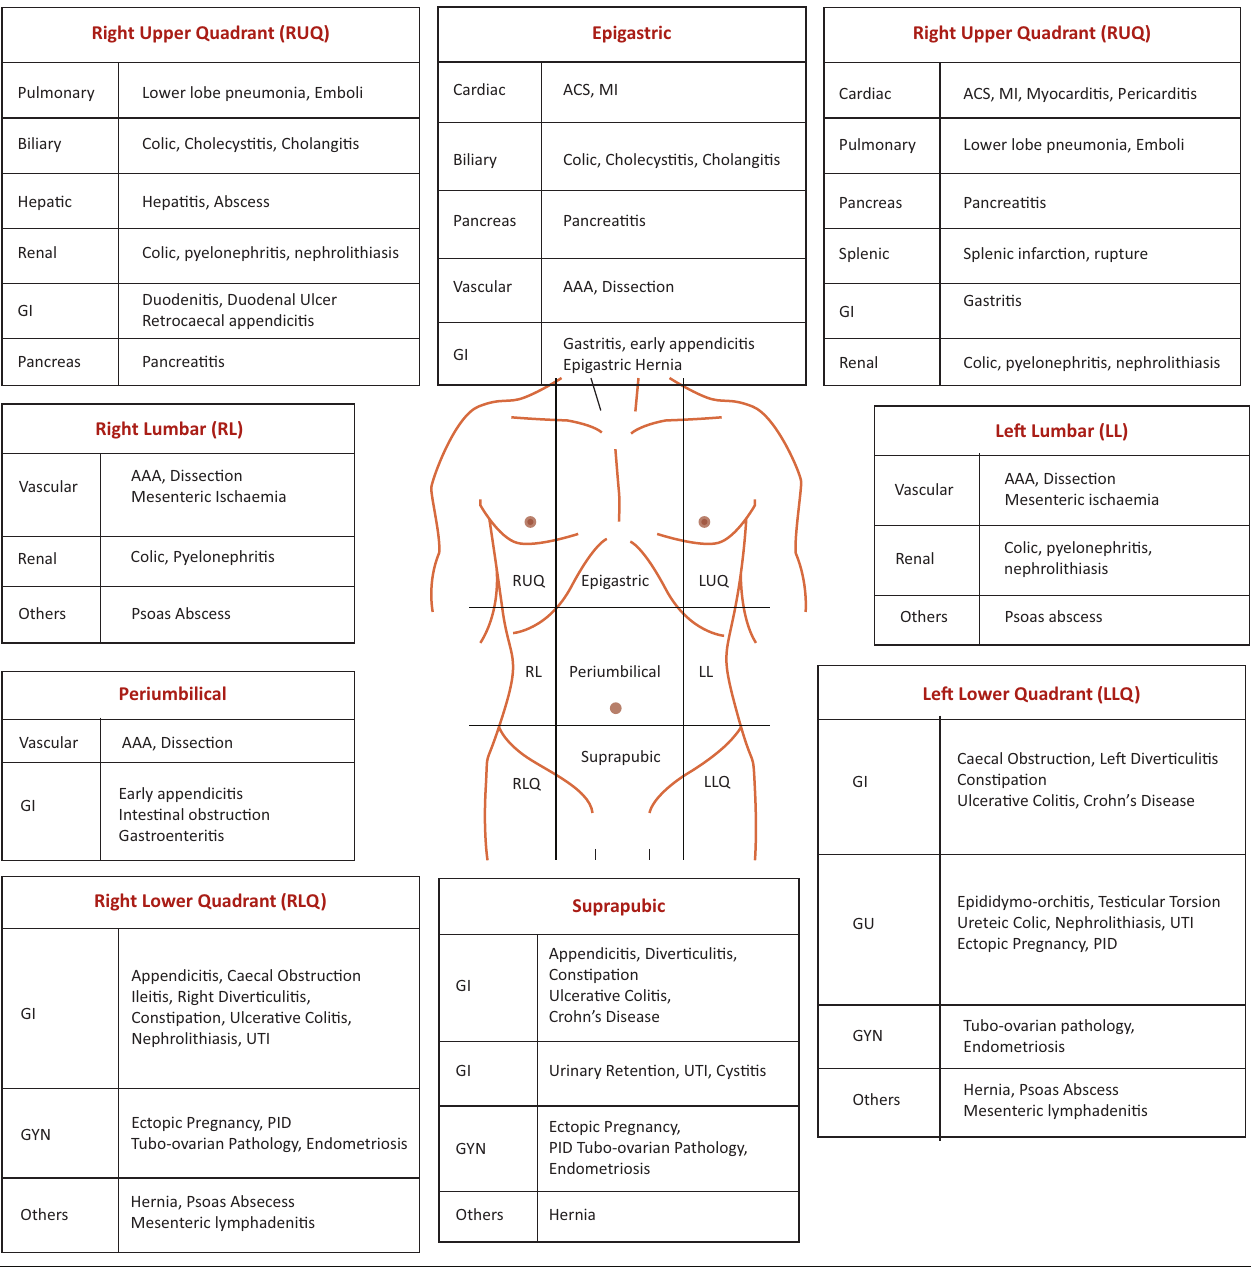
FIGURE 1: Anatomical localisation of